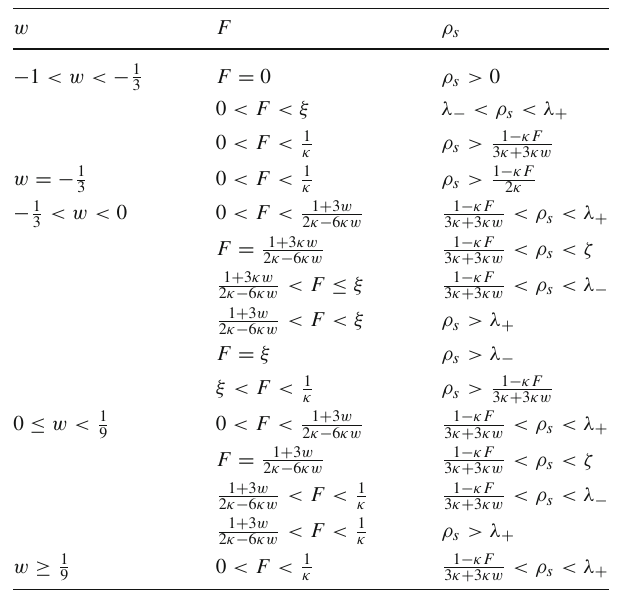
Table1 Summaryof thecombinations ofthe stabilityconditions under homogeneousscalarperturbationsandthatgiveninEq.(31)with K = 1 and κ >